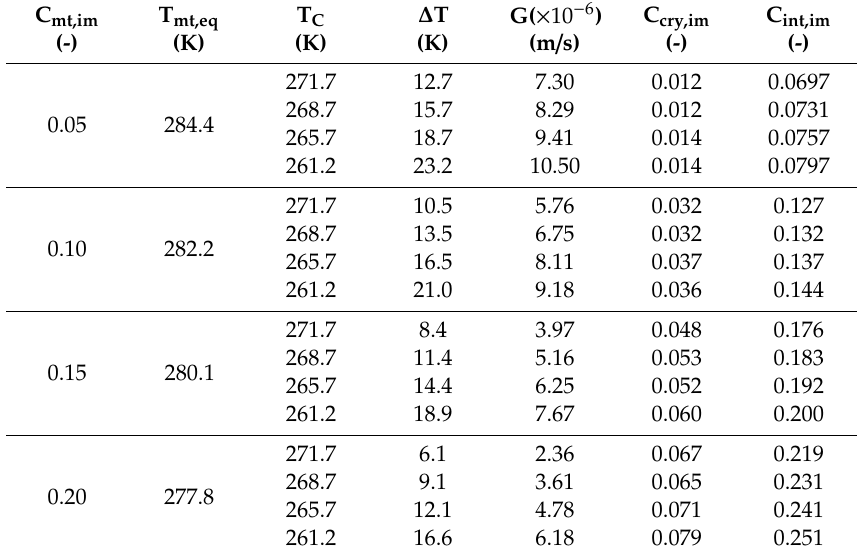
Table 2. The experimentally measured data of G and C cry,im for C mt,im = 0.05–0.20 operated at T C = 261.2–271.7 K from the binary PX / EB